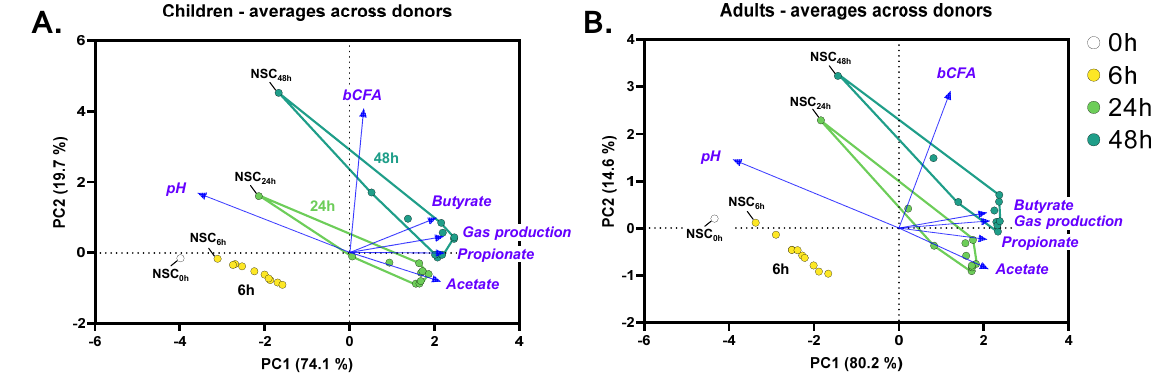
Figure 2. Kinetic sampling covered saccharolytic (0–24 h) and proteolytic fermentation processes (24–48 h). Principal component analysis (PCA) summarizing the levels of fundamental fermentation parameters (pH, SCFA, bCFA and gas production), as averaged across 6 children ( A ) or 6 human adults ( B ) at di ff erent time points (0 h, 6 h, 24 h, and 48 h) in the no substrate control (NSC) or upon treatment with reference prebiotics (FOS/IN), single HMOs or HMOs blends. SCFA—short-chain